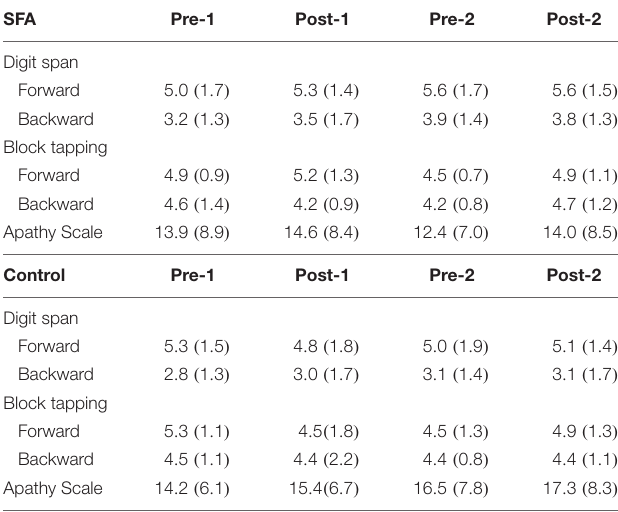
TABLE 2 | Mean cognitive and Apathy test scores in SFA and Control